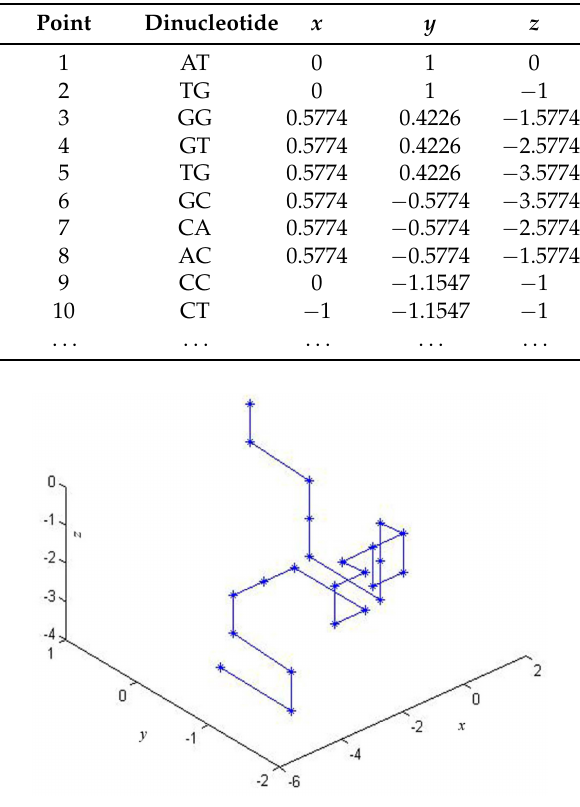
Table 2. Cartesian 3-D coordinates for the sequence ATGGTGCACCTGACTCCTGATCTGGTA.